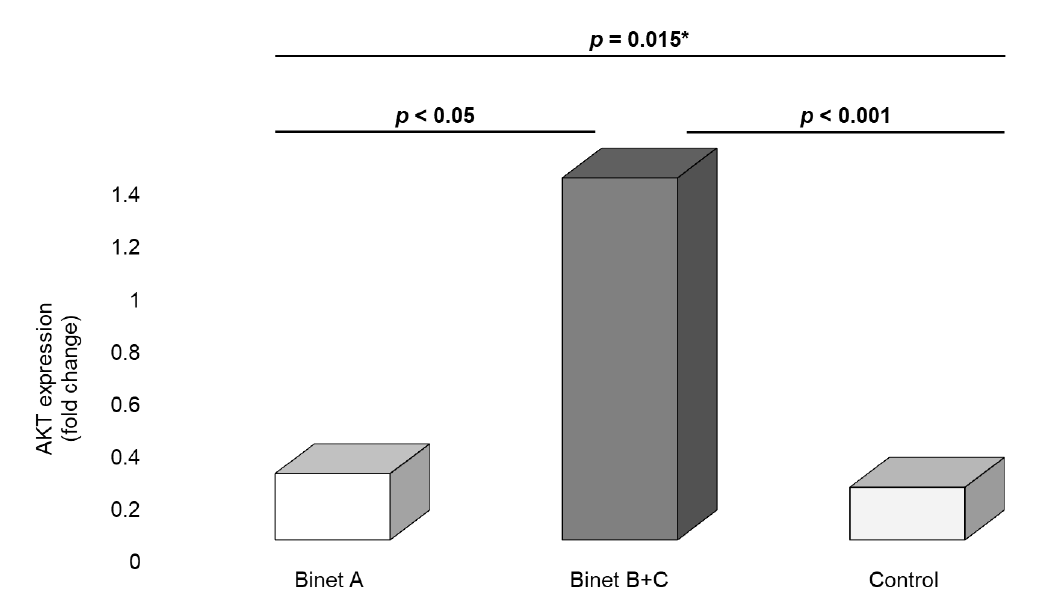
FIGURE 1 - AKT gene expression in Binet A, Binet B+C, and control groups; * p- value among CLL patients and controls. CLL: Chronic Lymphocytic Leukemia; CT: